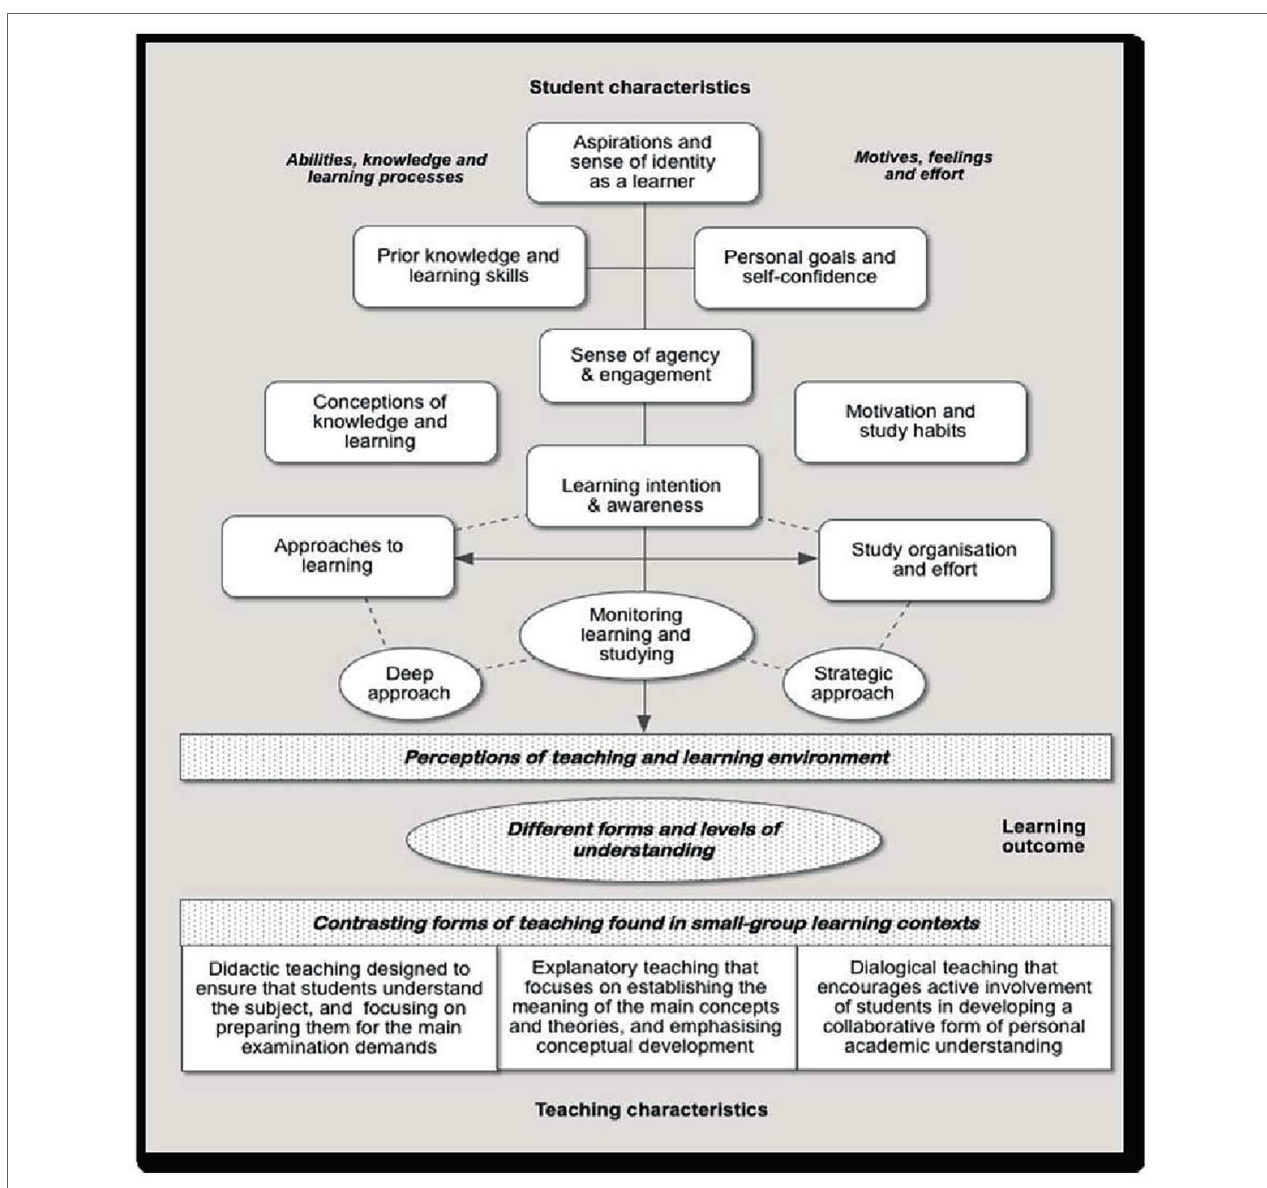
FIGURE 1 | Model of student and teaching characteristics and learning